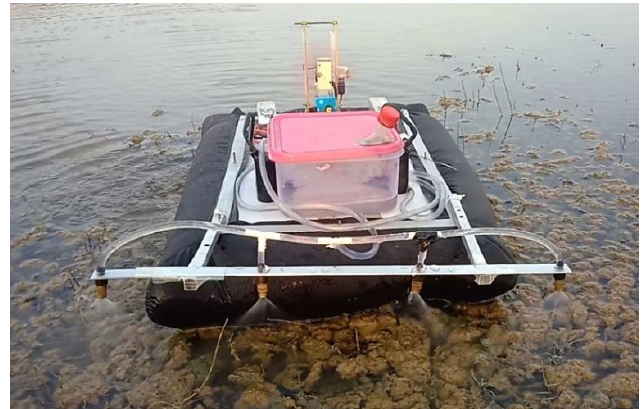
Figure 20. Testing of sprayer over